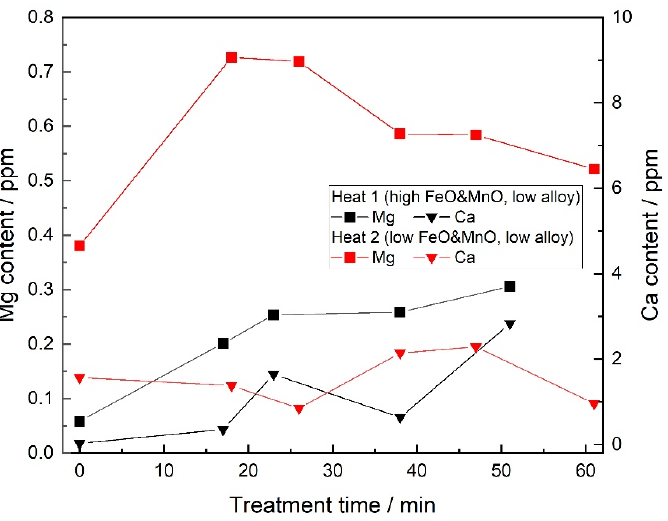
Figure 7. Comparison on the Ca and Mg contents between heat 1 and heat 2.